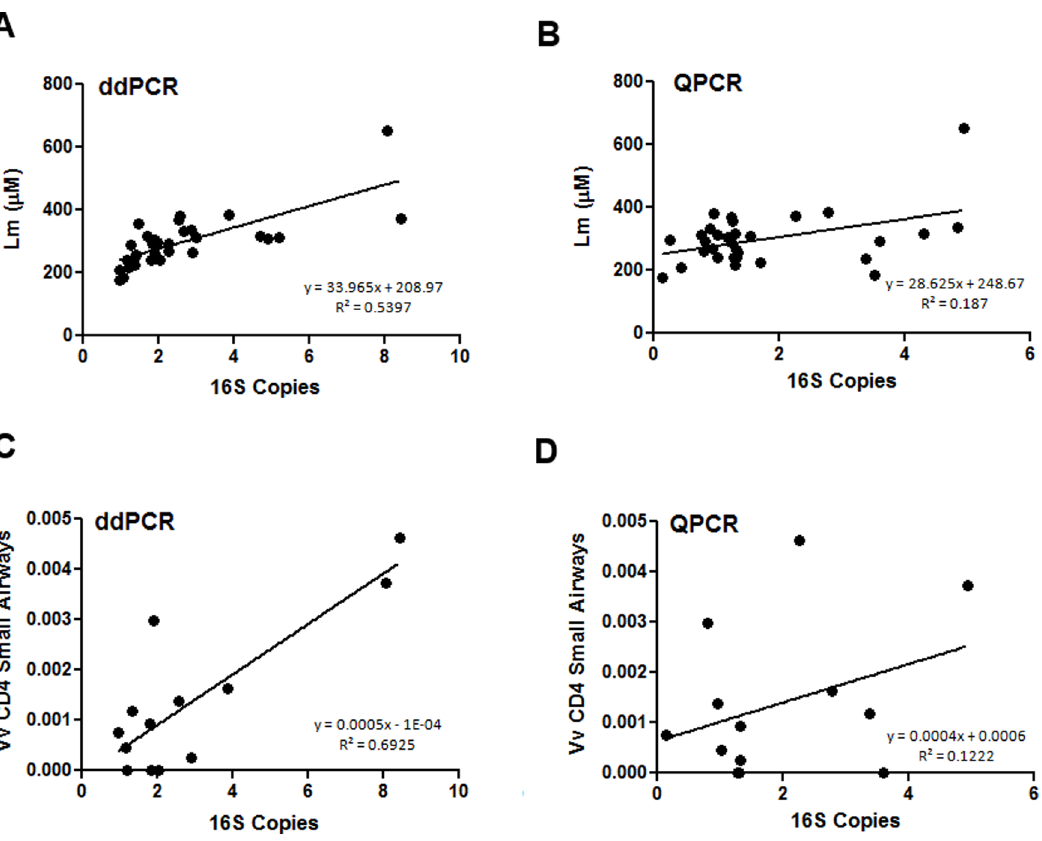
Figure 4. The relationship between quantitative histology parameters and ddPCR or QPCR measurements. A) ddPCR 16S bacterial loads versus the mean linear intercept (Lm). B) qPCR 16S bacterial loads versus the Lm. C) ddPCR 16S bacterial loads versus the small airway CD4 T-cell volume fraction (Vv). D) qPCR 16S bacterial loads versus the small airway CD4 T-cell Vv.